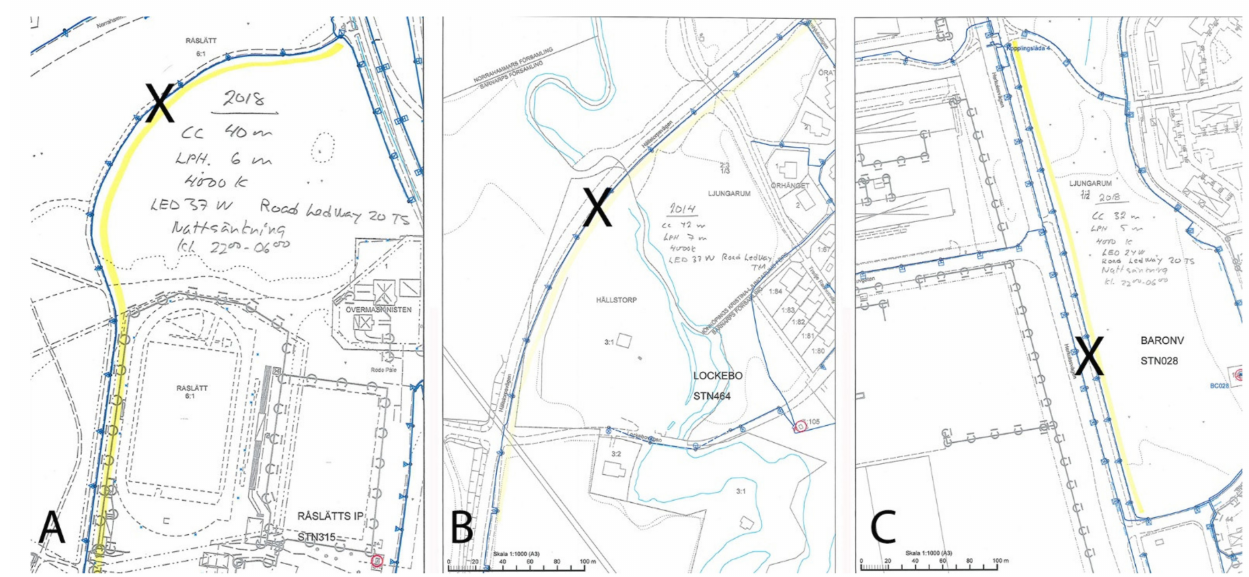
Figure 1. On the images with maps, we see the roads from left to right: ( A ) Råslätt; ( B ) Lockebo; ( C ) Ljungarum. The cross marks the position of photos and drawings.